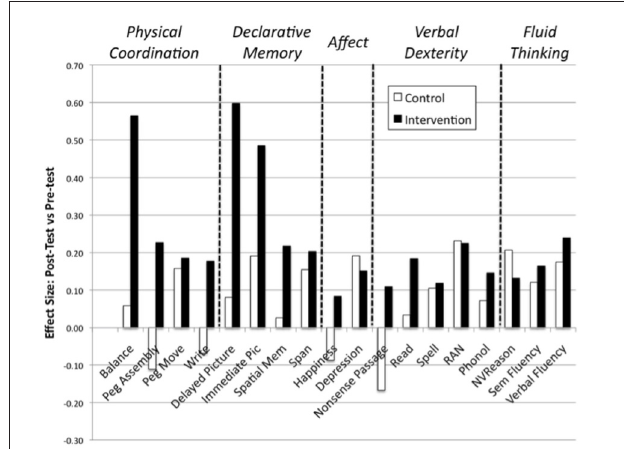
FIGURE 2 | Effect sizes for the variables of